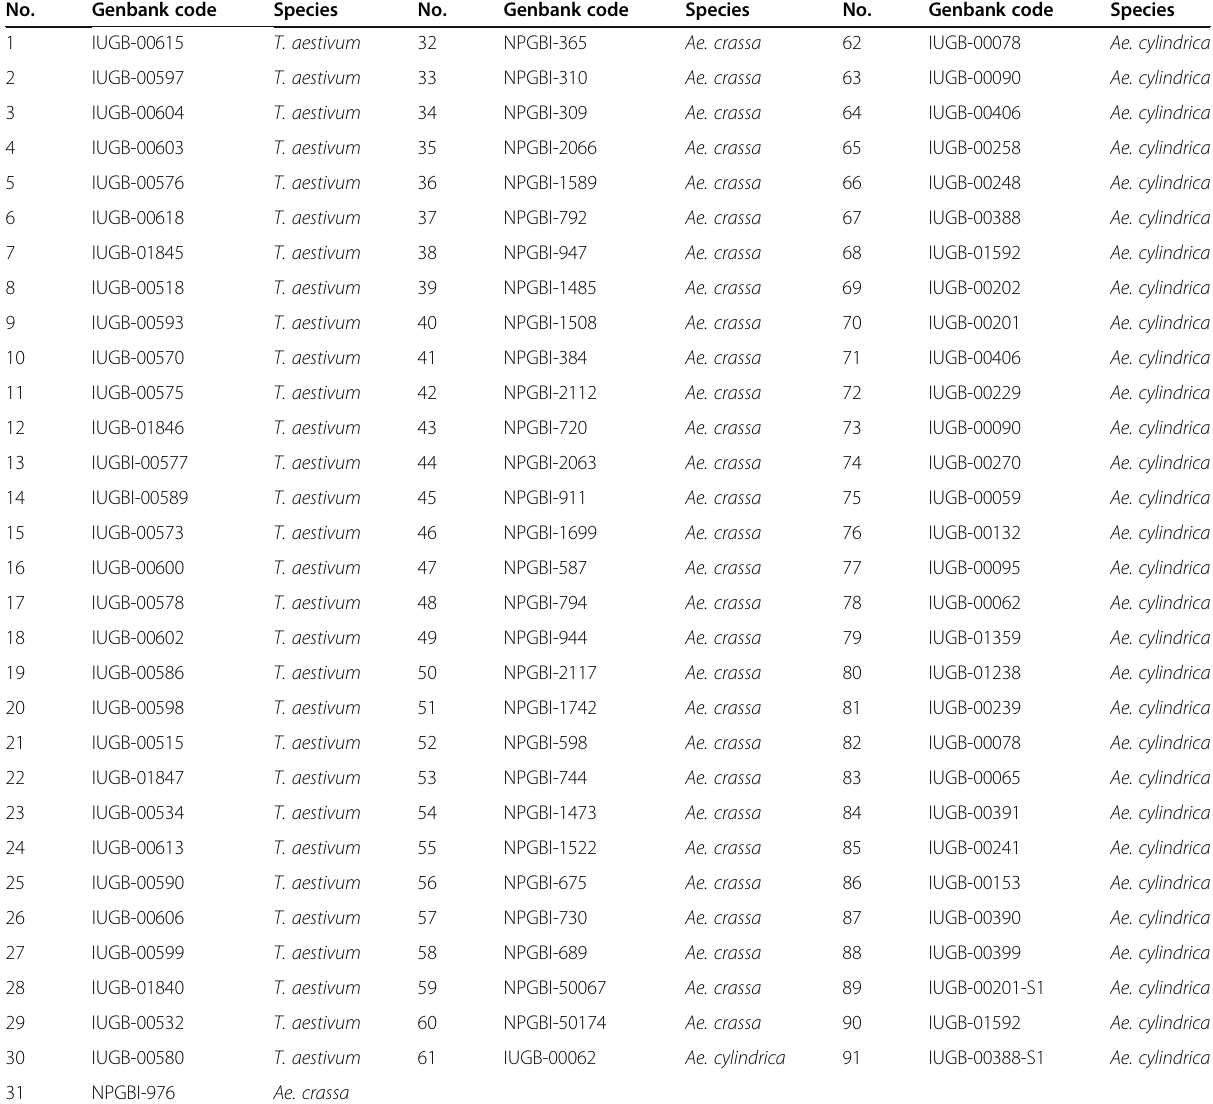
Table 1 List of the 91 investigated Triticum and Aegilops accessions